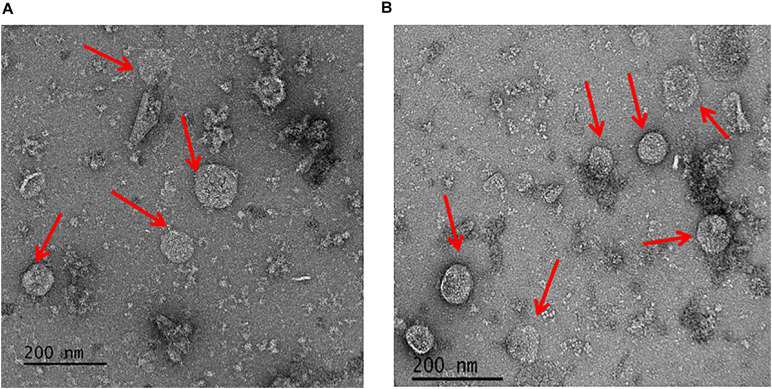
Electron micrographs of enriched BMCs. Isolated BMC particles from A. woodii cells grown on 1,2-PD (A) or from 2,3-BD (B). Arrowheads point to BMCs, size varied from 60–140 nm (particles number, n > 100).